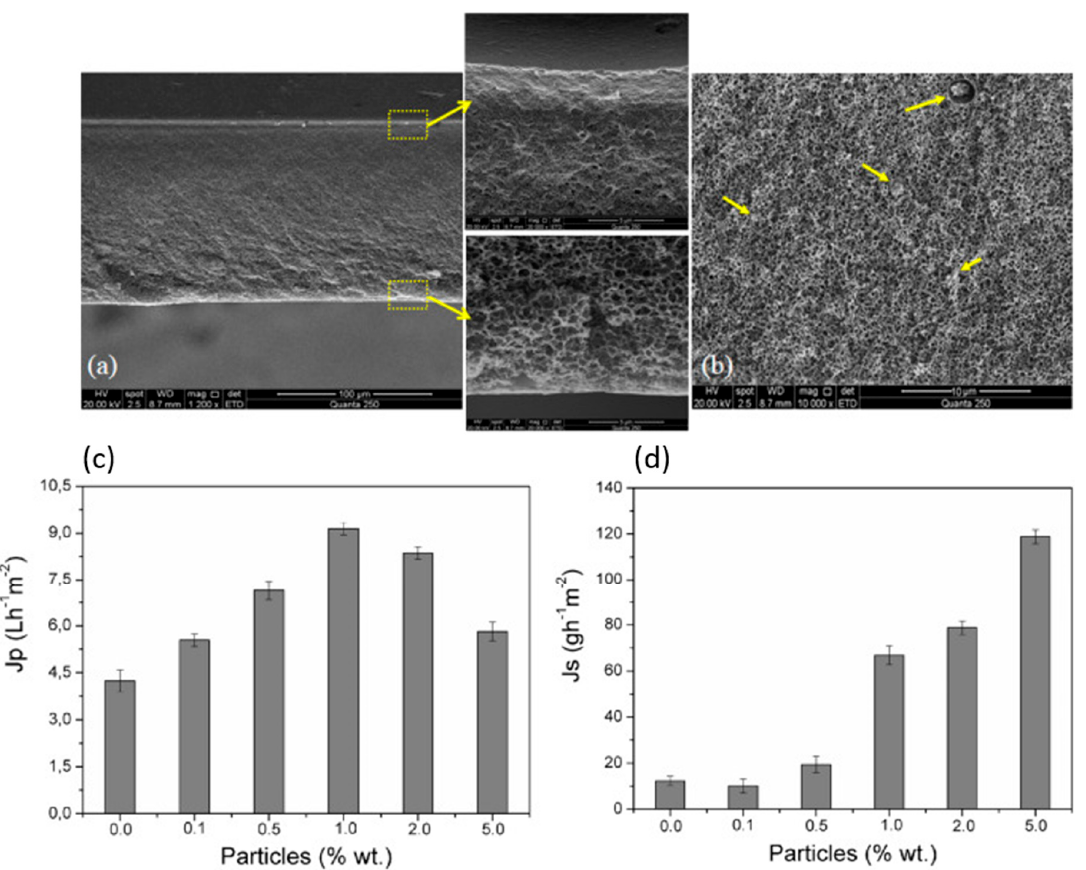
Figure 3 . SEM images of the anisotropic cellulose acetate/hydroxyapatite membranes with details of top and bottom layers ( a ); particle agglomerates observed in the cross-section of the membrane containing 5 wt. % hydroxyapatite (HA) ( b ); water ( c ); and salt flux ( d ) of the composite membranes obtained during permeation tests (reproduced with permission from Ref. [56]).